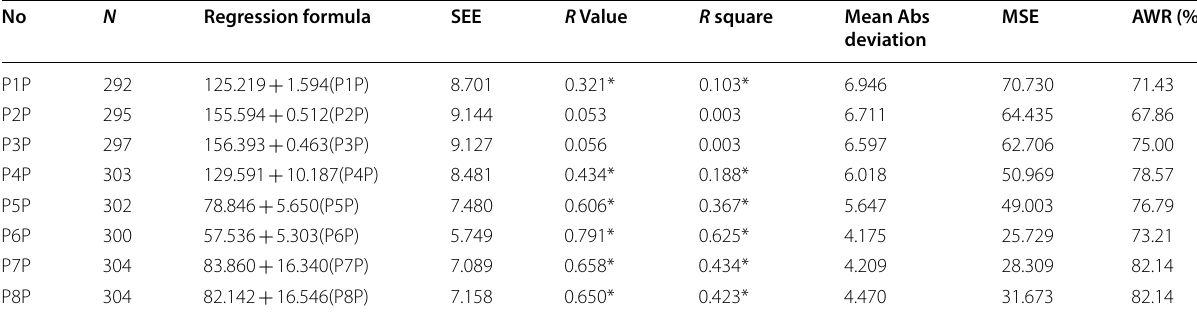
Unit in centimetre (cm) SEE represents the standard error of estimation for the generated regression formula; R value represents the Pearson correlation coefficient; Sig. value represents the significant values of the regression ANOVA corresponding to the F value * p < 0.05